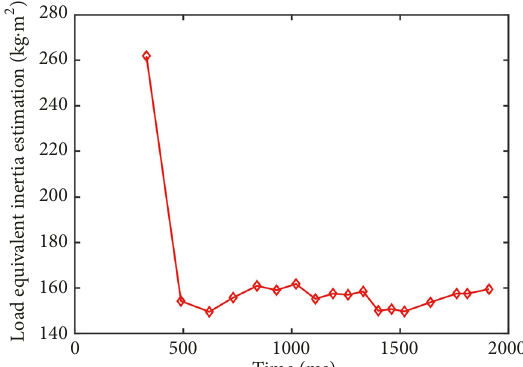
Figure 7: RLSE of the load equivalent inertia during AMT startup under the first gear.